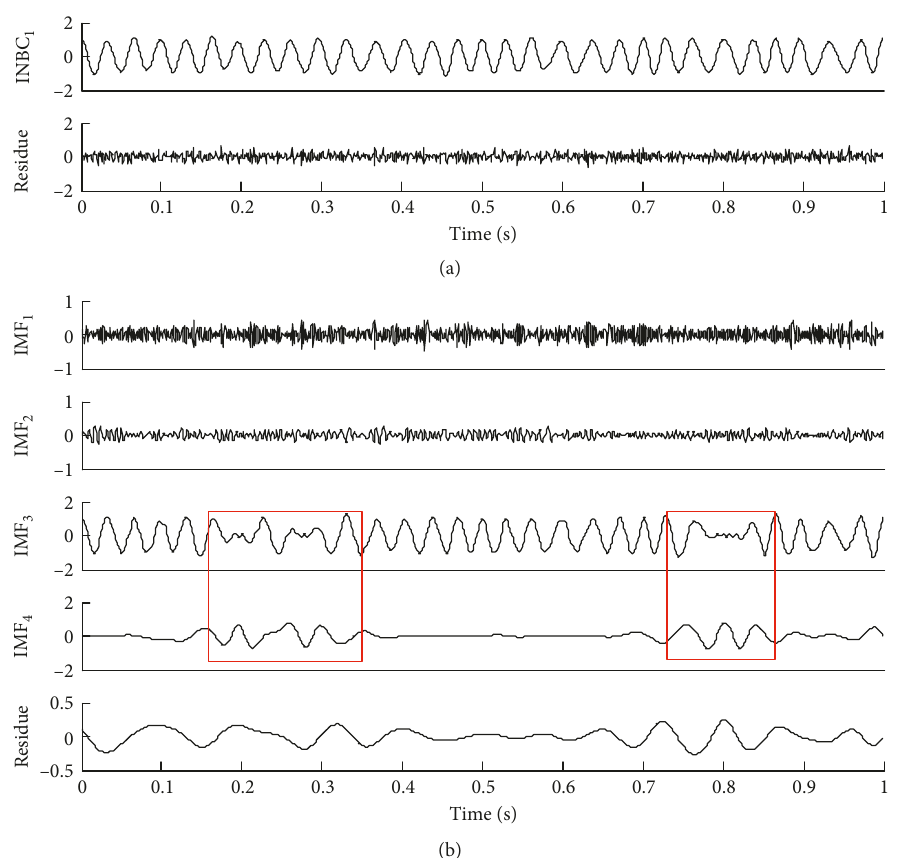
Figure 8: The decomposition results generated by ASNBD and EMD of simulation signal x decomposition results of (a) ASNBD; (b)